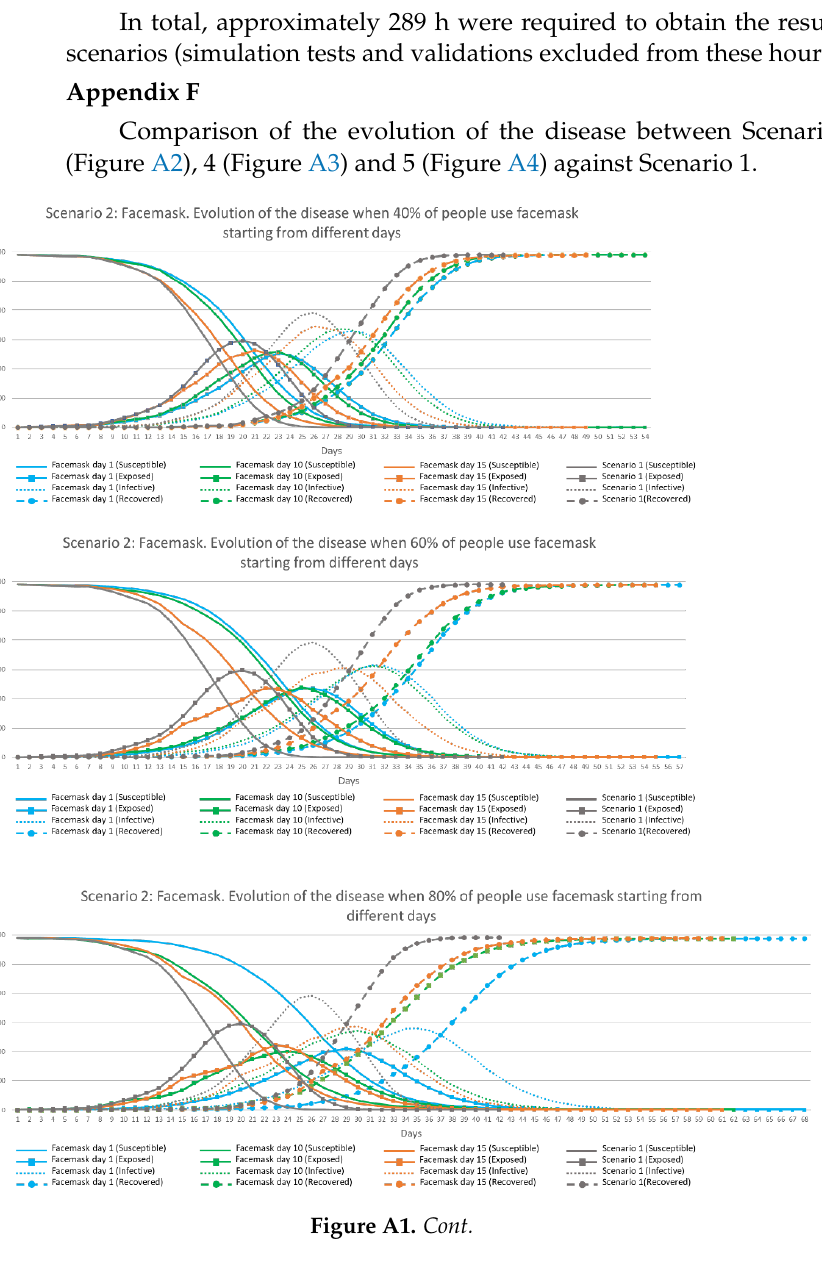
Figure A1. Comparison of the evolution of the disease between Scenarios 2 (Facemask Use) against Scenario 1 (No Measures).